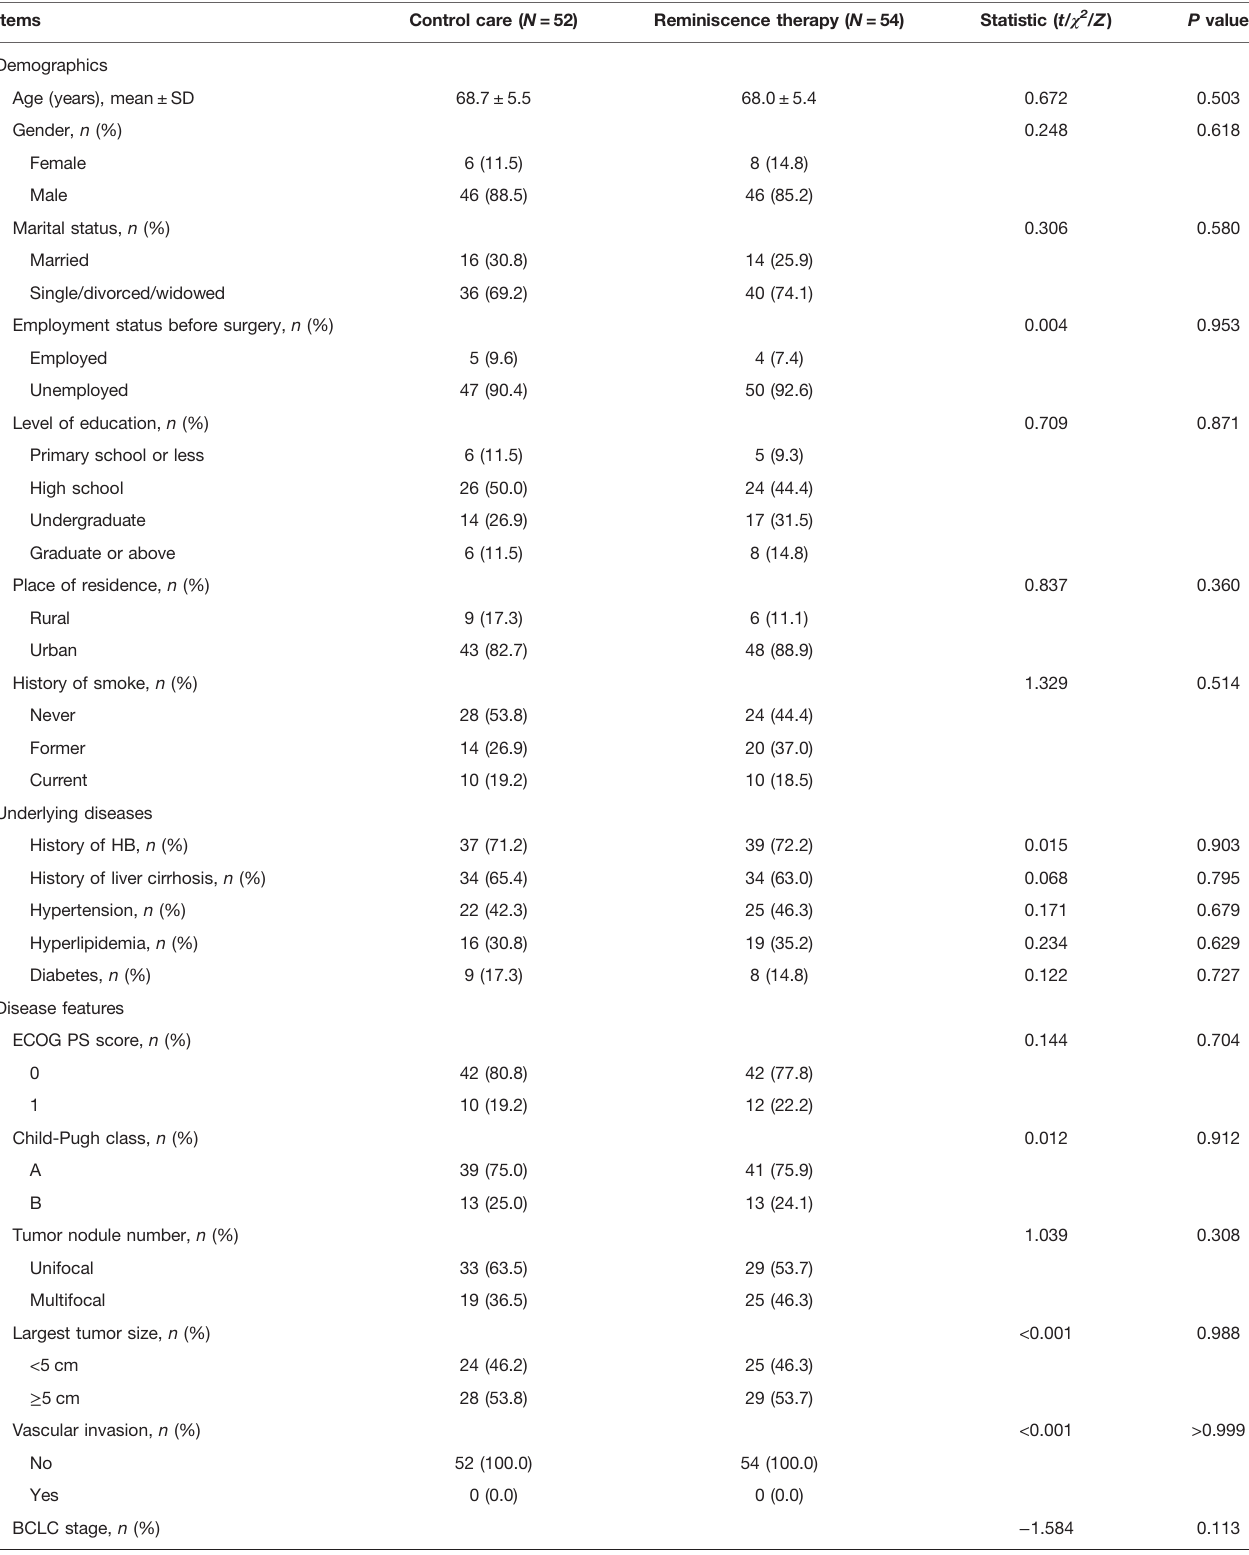
TABLE 1 | Characteristics of